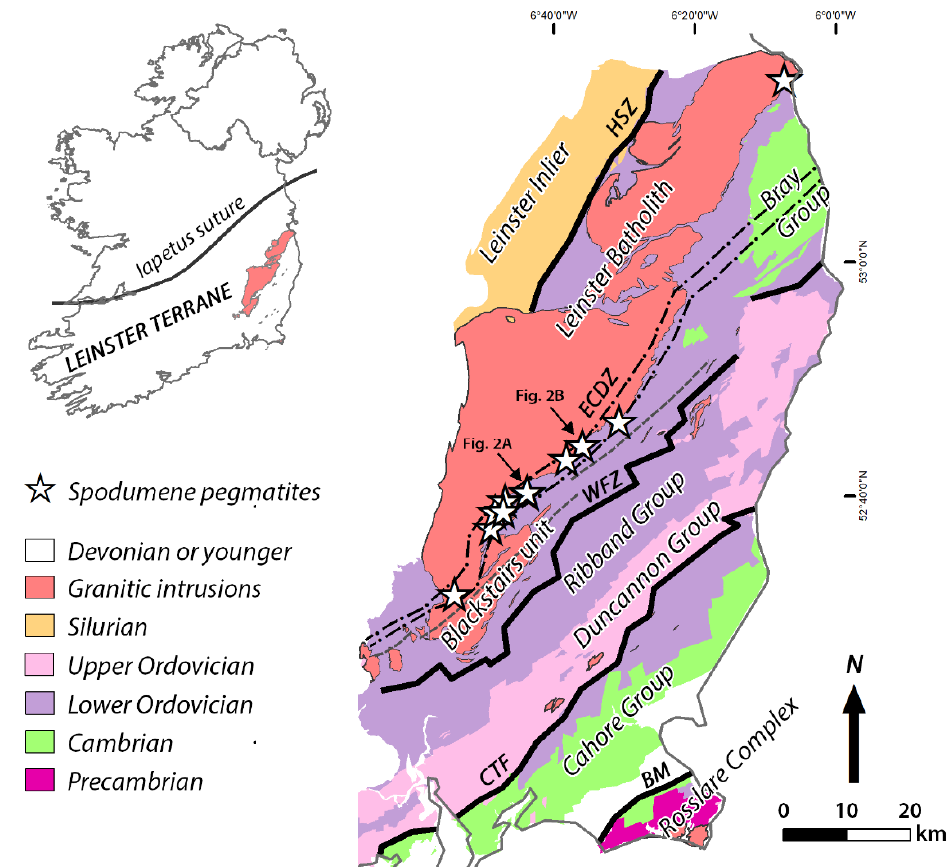
Figure 1. Simplified overview of the geology of the Leinster Terrane, south of the Iapetus suture, southeast Ireland. The Iapetus suture is according to [27]. The Leinster Batholith is shown in both overview (top left, inset) and the main map; major structures from the left: HSZ = Hollywood Shear Zone, ECDZ = East Carlow Deformation Zone [28]; WFZ = Wicklow Fault Zone [31]; CTF =